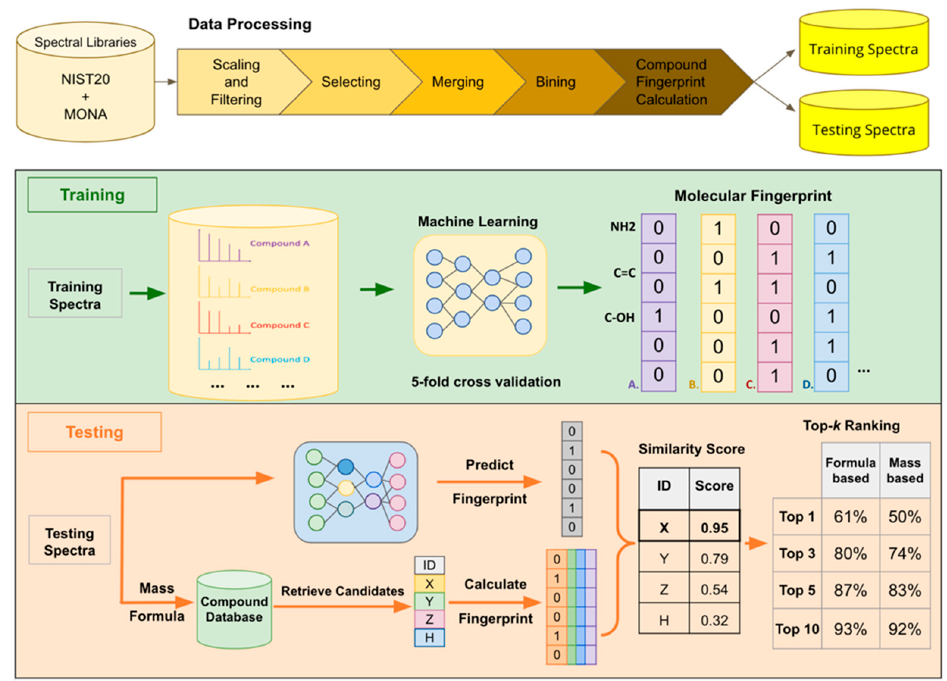
Figure 1. Machine learning-based compound fingerprint prediction for metabolite